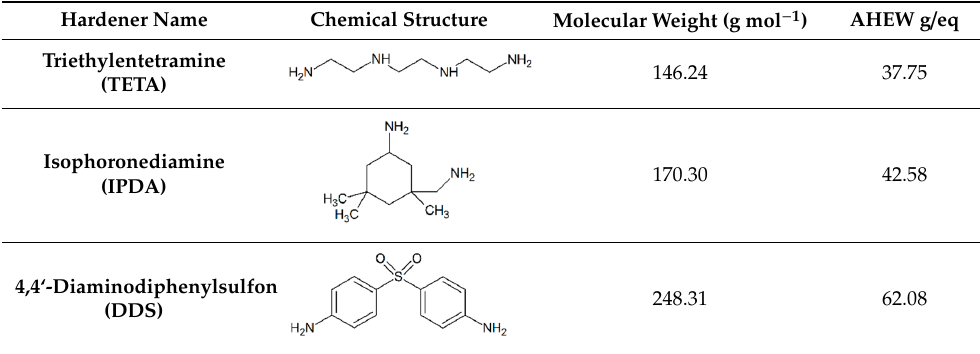
Table 1. Chemical properties of hardener used to prepare the samples and laminates.